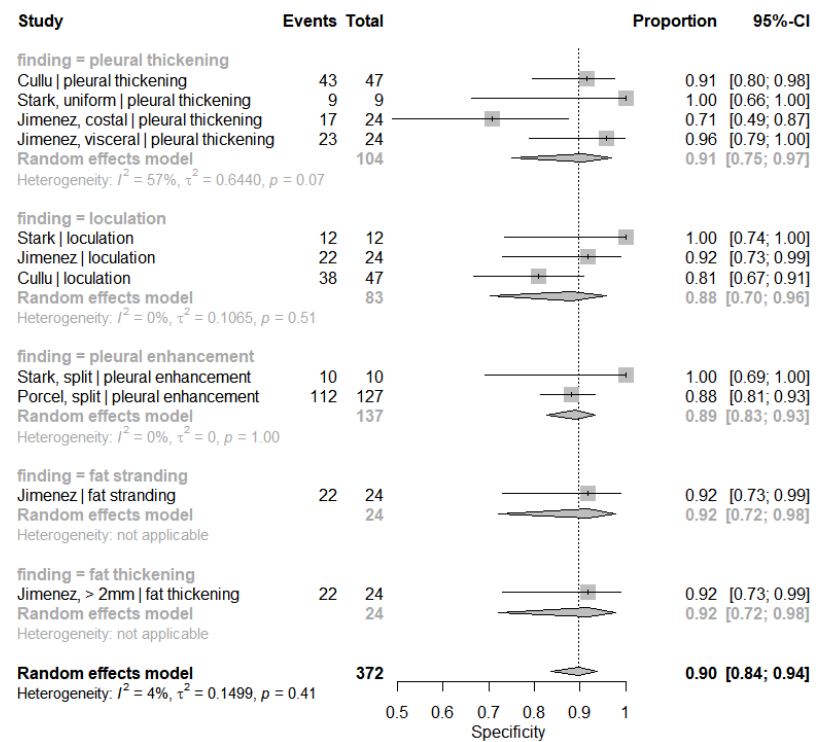
Figure A2: Specificity of informative pleural findings to detect pleural empyema in parapneumonic effusions